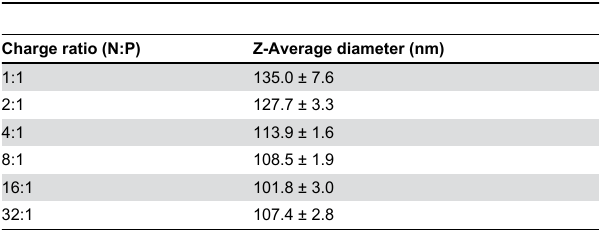
/plasmid DNA binary 11